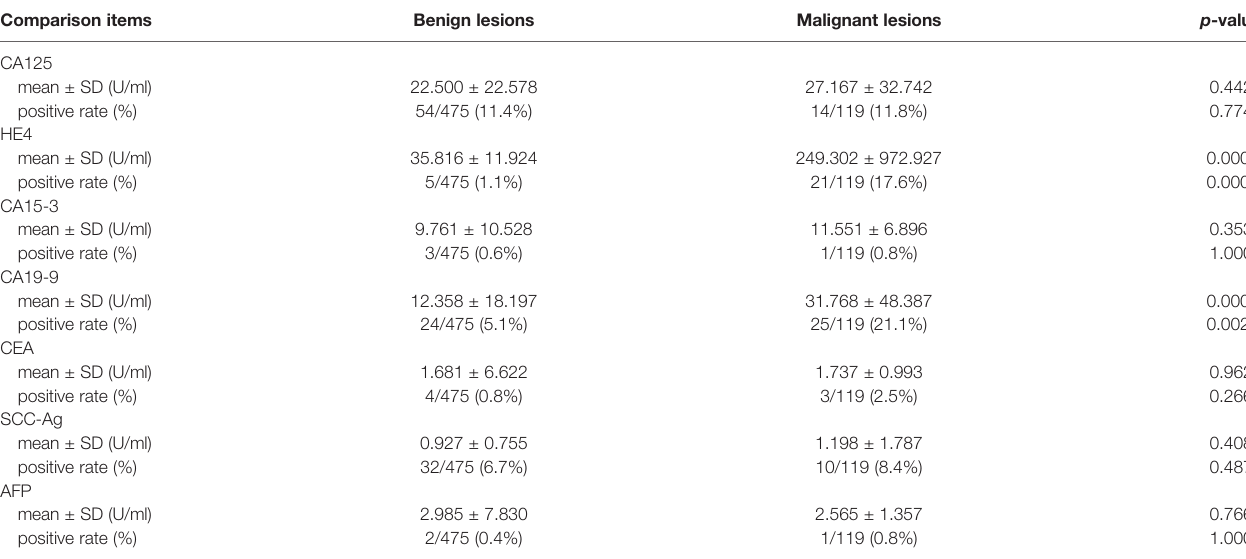
TABLE 5 | A summary table of the speci fi c values and positive rates of seven female tumor markers. Comparison